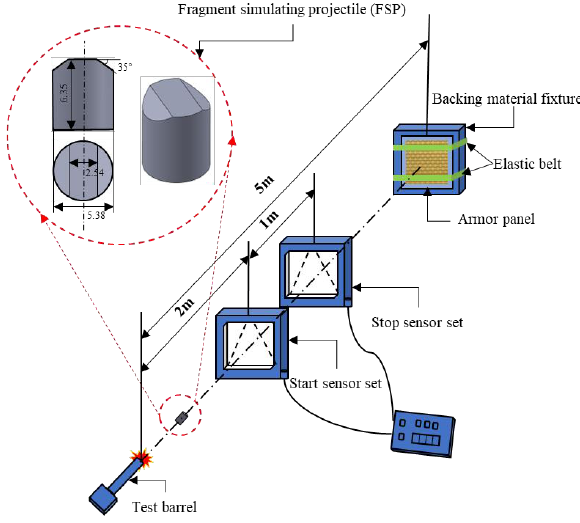
Figure 4. Schematic diagram of ballistic limit V50 test system.